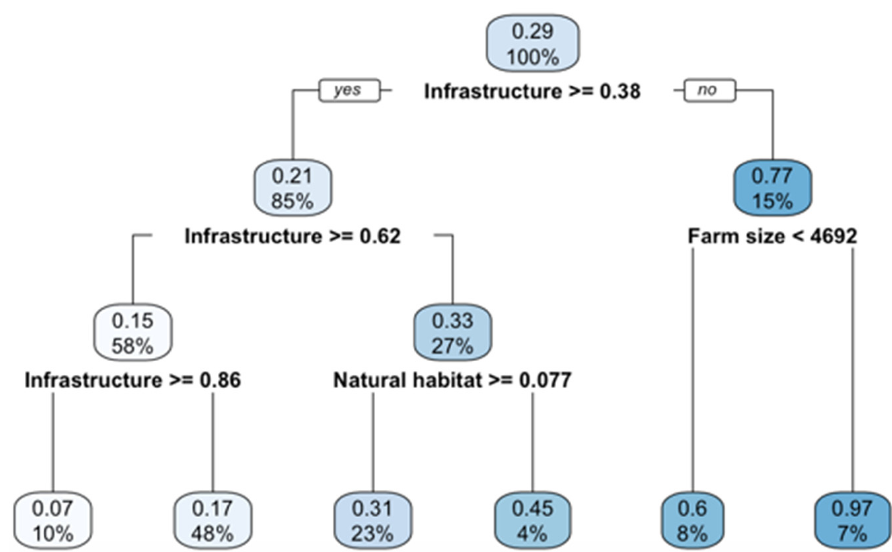
Figure 2. CART analysis of explanatory variables (proportion of infrastructure, non-crop area and overall size) predicting the proportion of production area. When conditions of significance are met, the graph branches and lists the value of the explanatory variable.